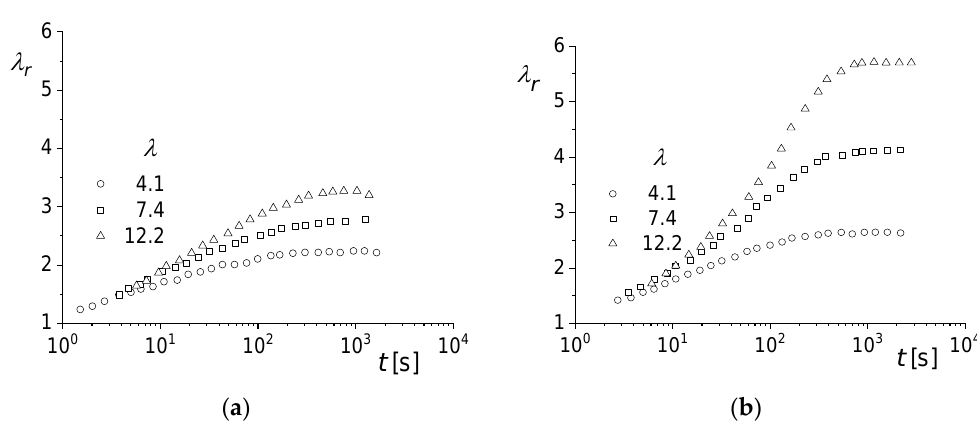
Figure 16. Recoverable stretching ratio 𝜆 𝑟 as a function of the recovery time 𝑡 for ( a ) PS and ( b ) PS/LLDPE 85/15 after different stretching ratios 𝜆 . The samples were uniaxially elongated at 𝜀̇ = 0.1 s −1 and 𝑇 = 170 °C [31].